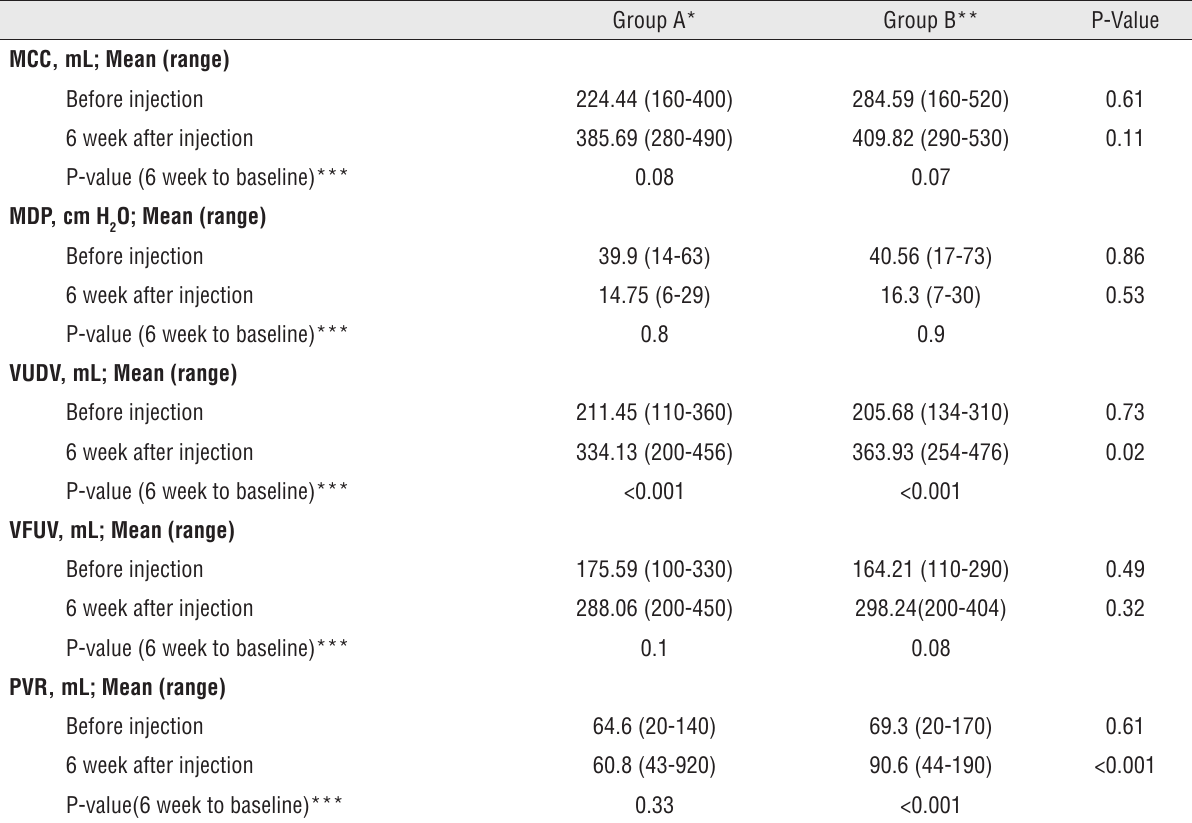
Table 2 - cystometric parameters at baseline and at 6 weeks after Abobotulinum toxin